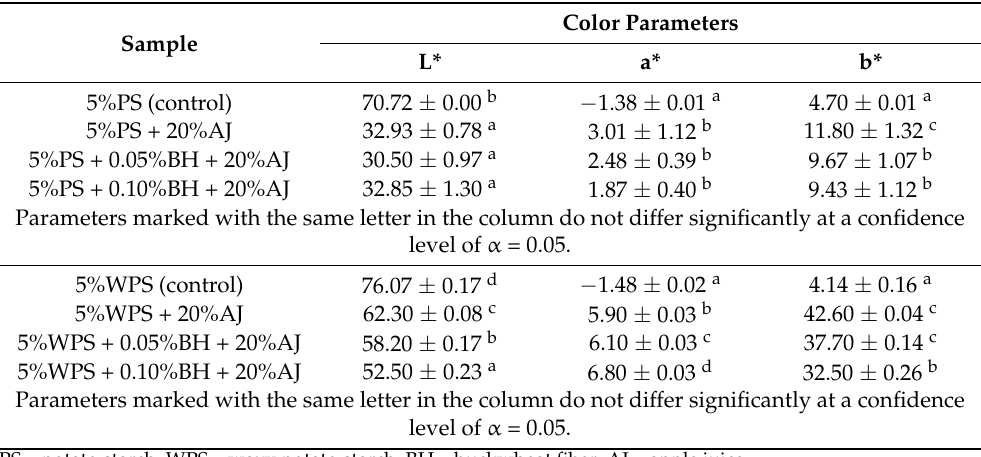
Table 6. Color parameters (L*, a*, and b*) of samples with normal and waxy potato starch, buckwheat fiber and juice.